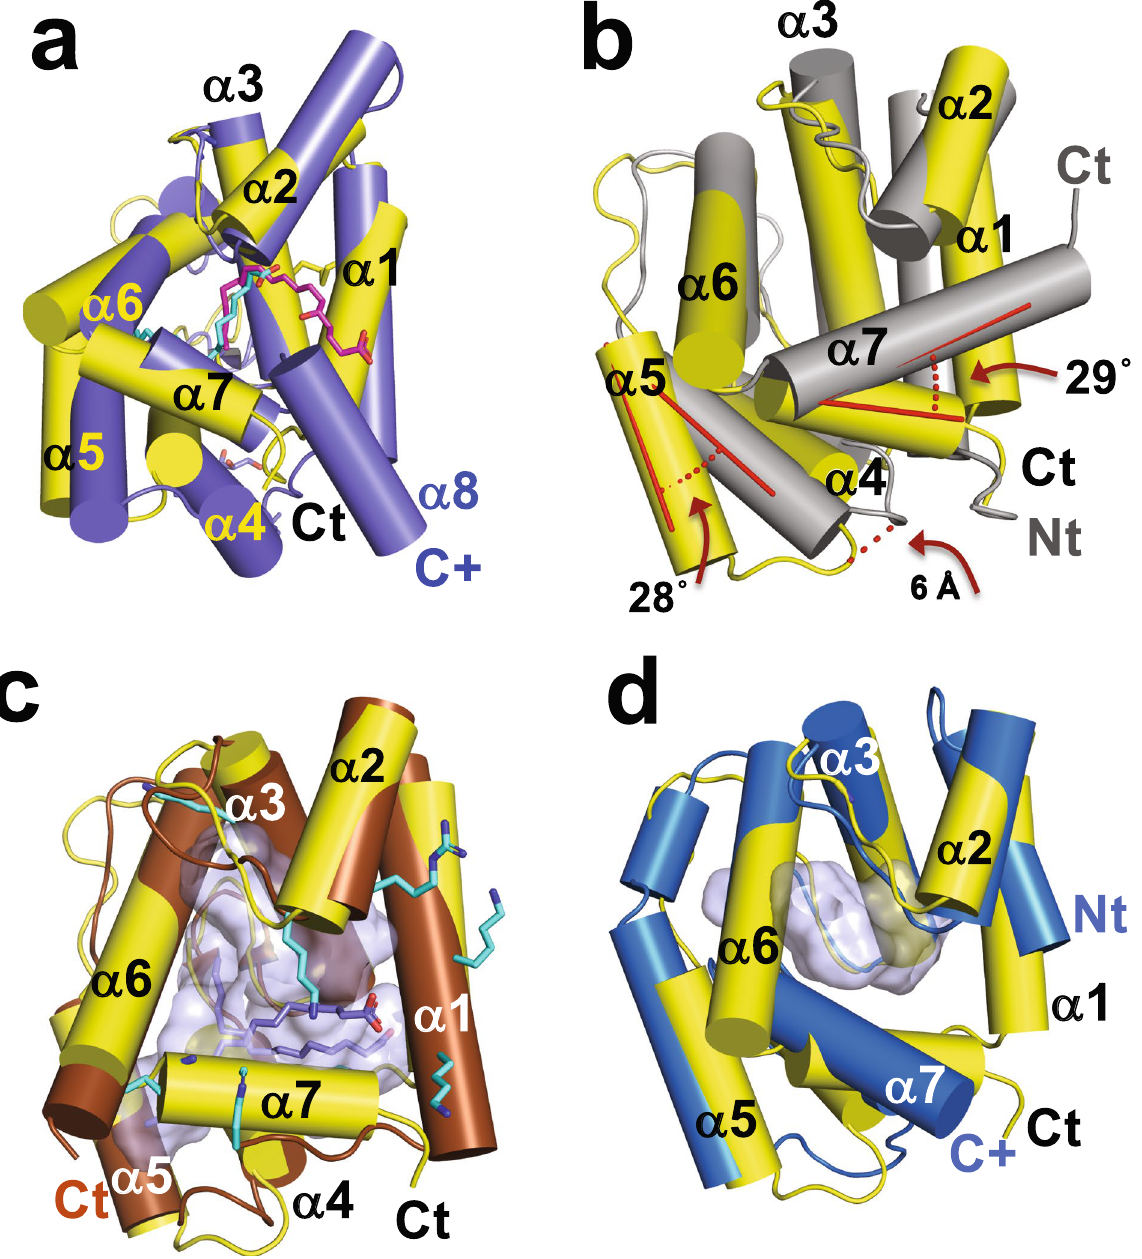
Figure 7. Comparison of AeOBP22 with known structures. Cylinder representation of AeOBP22 in yellow (N and C-termini labeled in black) compared with (a) N-terminal OBP domain of An. stephensi D7 (blue) bound to Leukotriene C4 magenta (PDB 3NHI) 67 . For clarity, the C-terminal domain, which continues at the position labeled C + in blue, is not shown. The linoleic acid bound to AeOBP22 is shown in cyan. (b) LmigOBP1 (grey) (PDB 4PT1) 69 . The difference in the positions of helices 5 and 7 are shown in red. (c) Phormia regina OBP56a bound to multiple molecules of palmitic acid (blue) (PDB 5DIC) (Ishida et al . not published). The multiple lysines and arginines that surround the pocket (grey) are shown in cyan. (d) An. gambia e OBP22 (bright blue) (PDB 3L4L) ( Zhang and Ren, not published). The C-terminus of AgOBP22 is mostly unstructured (extends from position labeled with blue C +